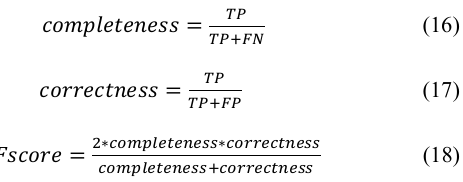
Figure 14 is the extracted marking of samples point cloud data with their own max 𝐹𝑠𝑐𝑜𝑟𝑒 . Table 1 is the evaluation of extracted marking of samples.